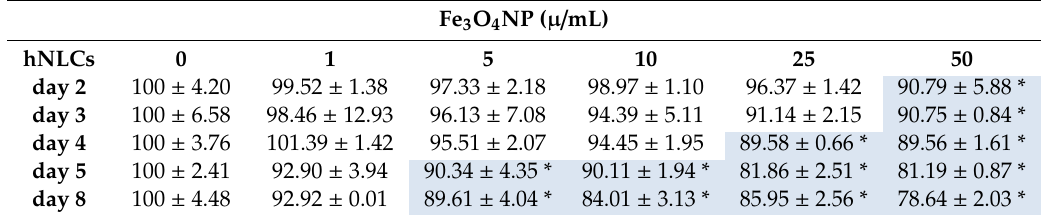
Table 4. Cell viability evaluation in hNLCs plus Fe 3 O 4 NPs (1–50 µ g / mL) over